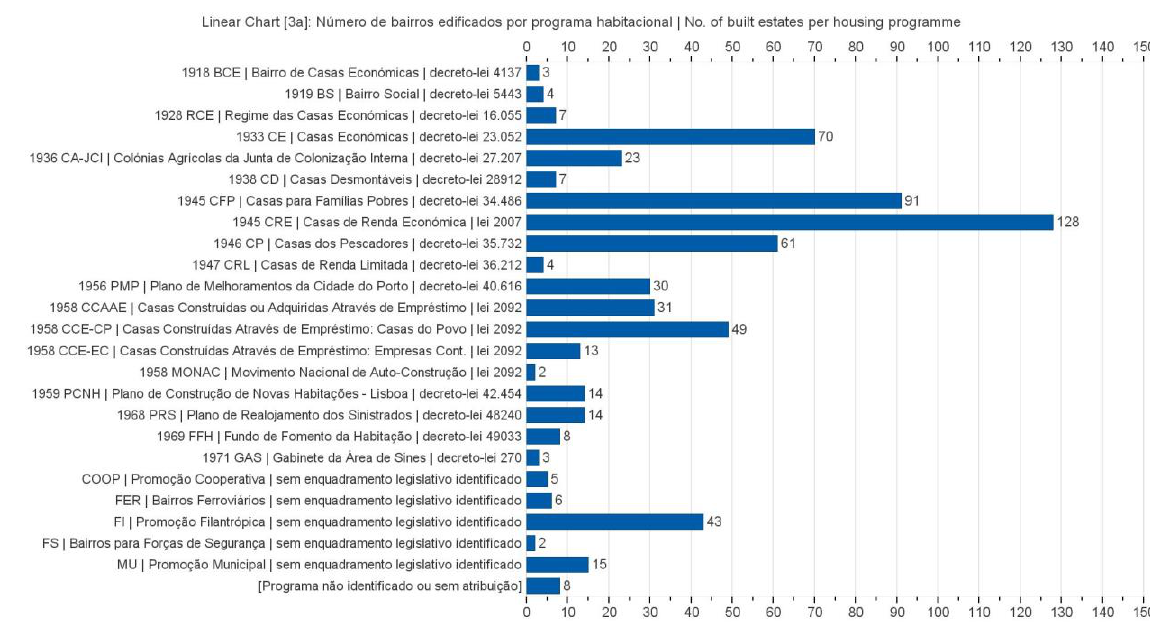
estates and phases included in MdH between 1910 and 1974, and number of dwellings. Error factors: in some cases, the